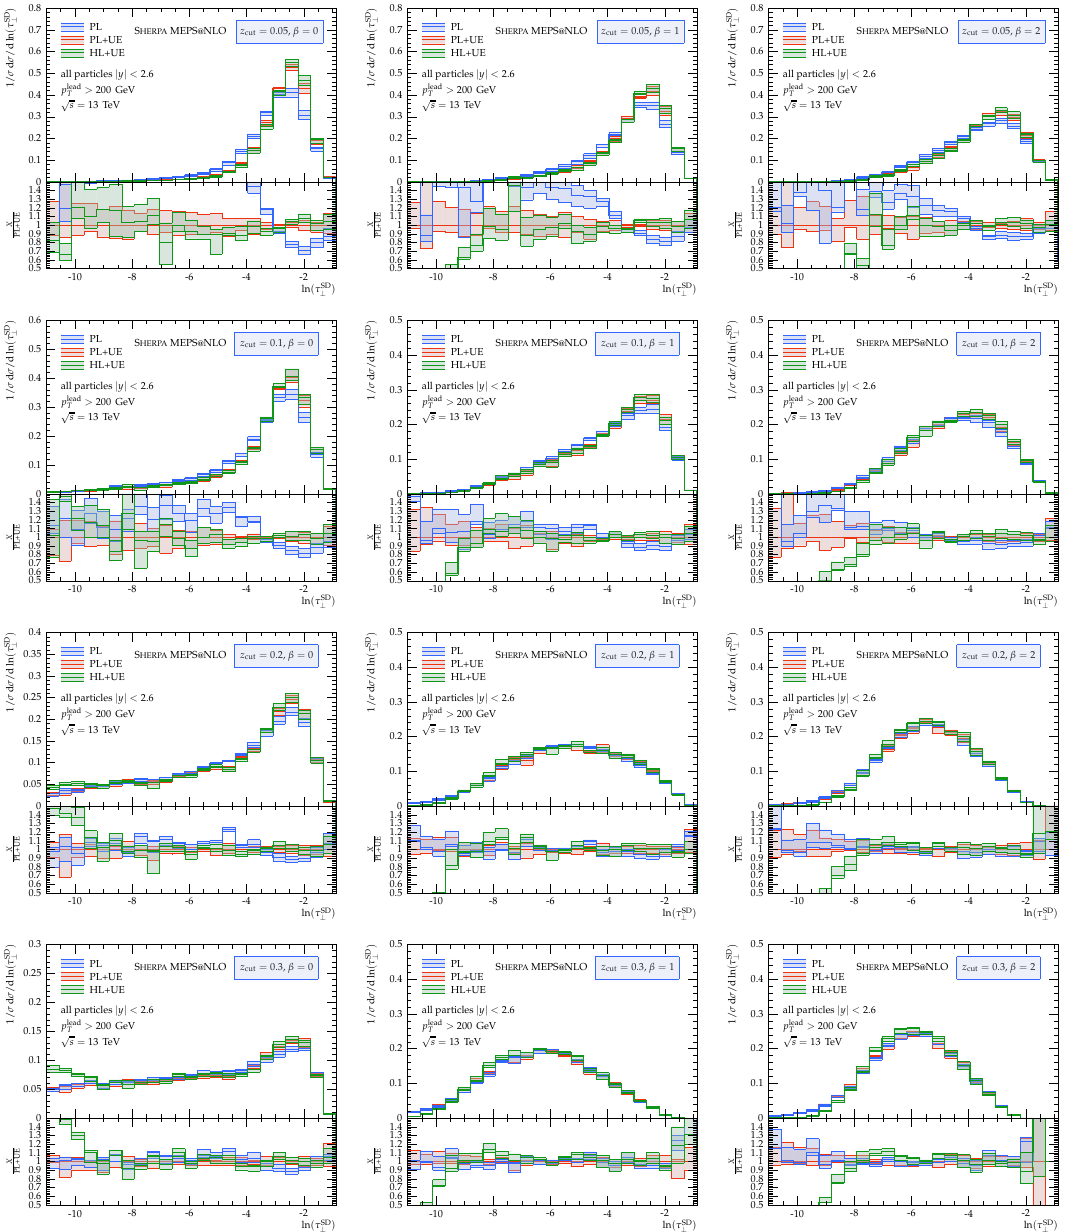
Figure 12 . The groomed thrust distributions for β ∈ { 0 , 1 , 2 } (columns) and z cut ∈ { 0 . 05 , 0 . 1 , 0 . 2 , 0 . 3 } (rows) for the p T, min = 200 GeV event selection. The lower panels show the ratios with respect to the parton-level simulation including the underlying event (PL+UE)